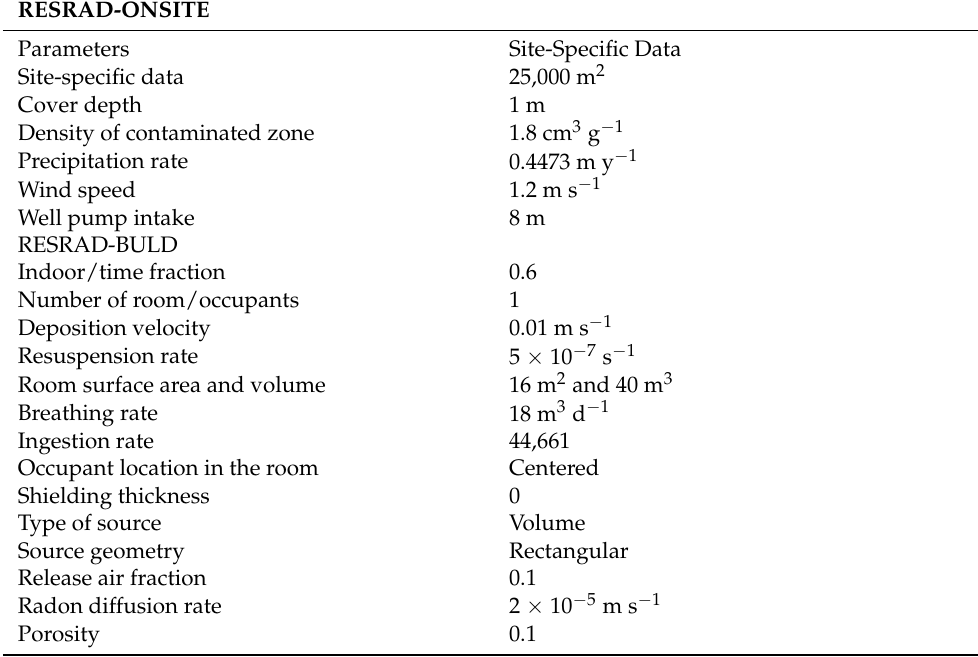
Table 1. Input parameters for RESRAD